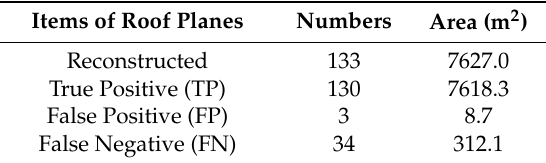
Table 4. Roof segmentation: Quantitative assessment with respect to the reconstructed objects.